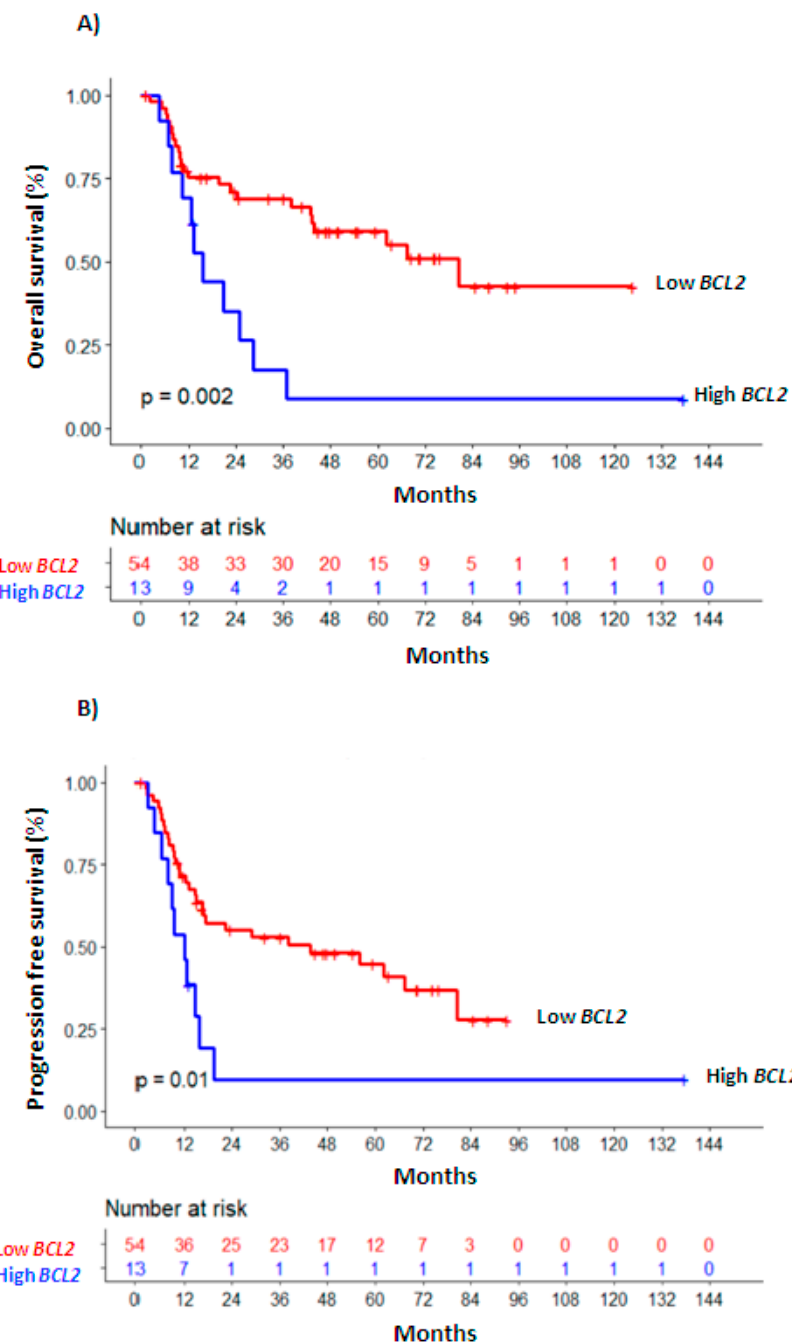
Figure 1. Overall survival ( A ) and progression-free survival ( B ) Kaplan—Meier curves of patients with high vs. low BCL2 expression levels.